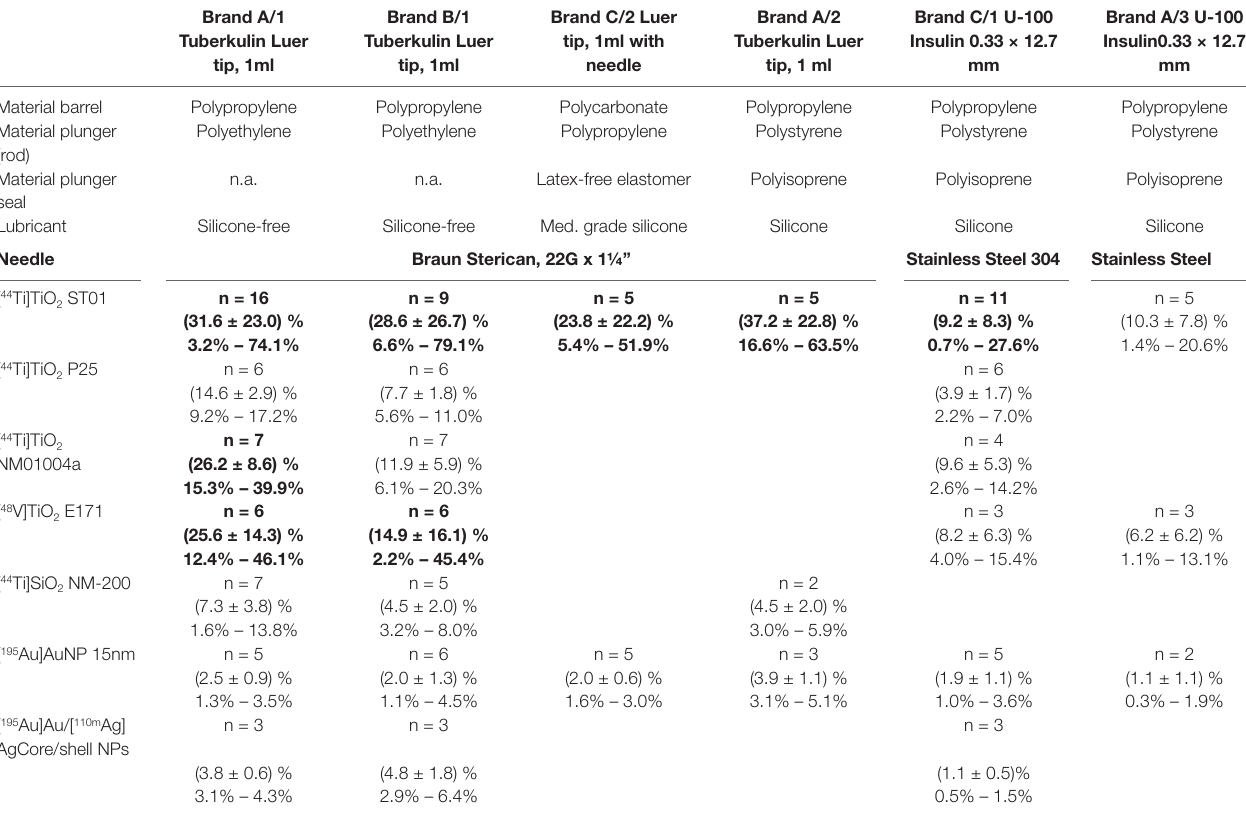
TABLe 2 | Summary of the JRC syringe retention measurements; The number n of syringes is presented, the mean retention value ± its standard deviation in percent and the range from the lowest to the highest determined retention